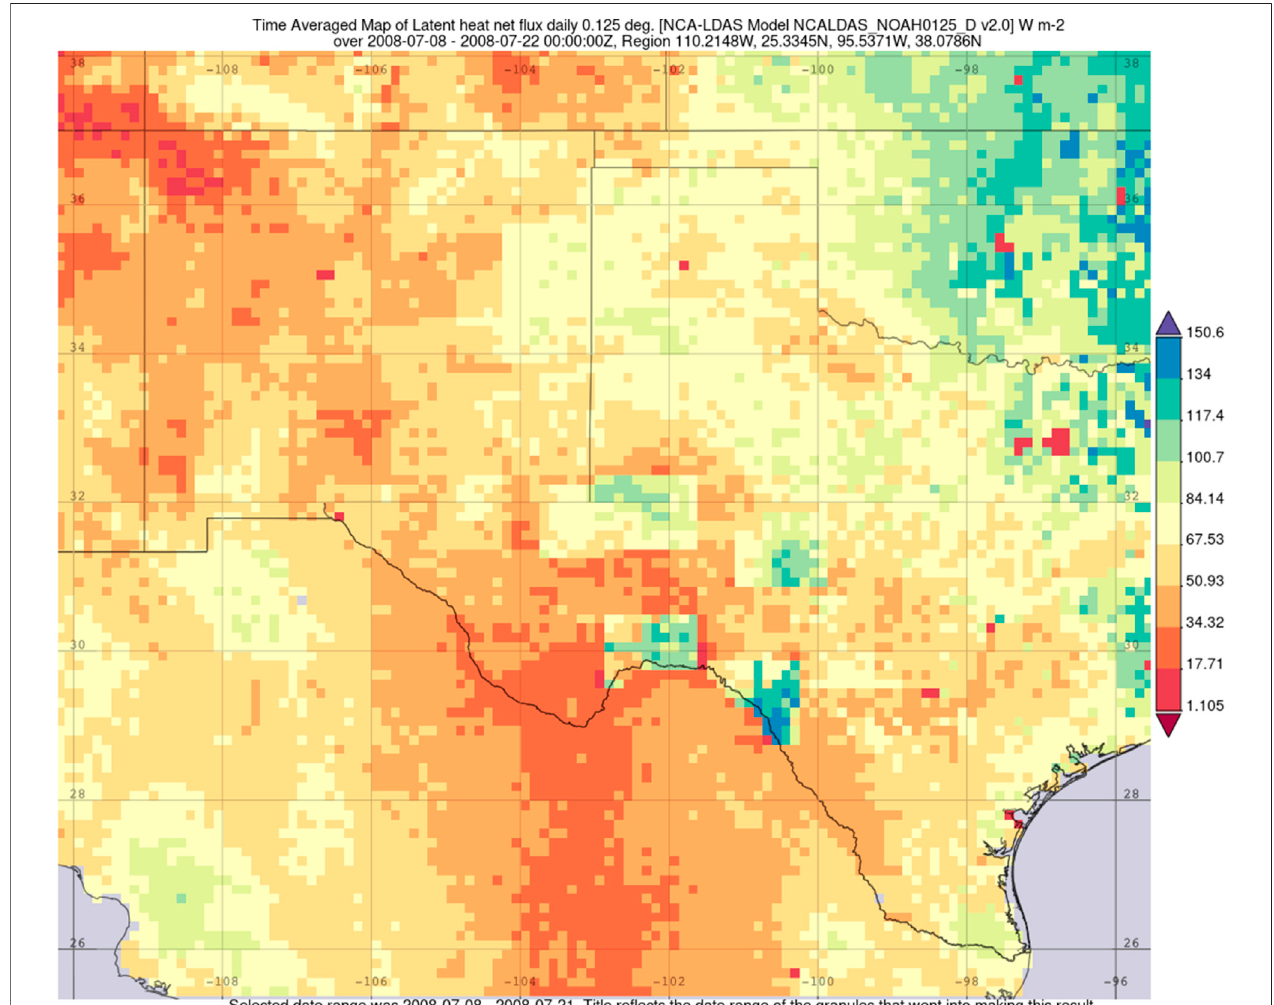
FIGURE 10 | Two week averaged latent heat (W m − 2 ) from the NCA-LDAS model prior to Hurricane Dolly. Source: NASA GIOVANNI.